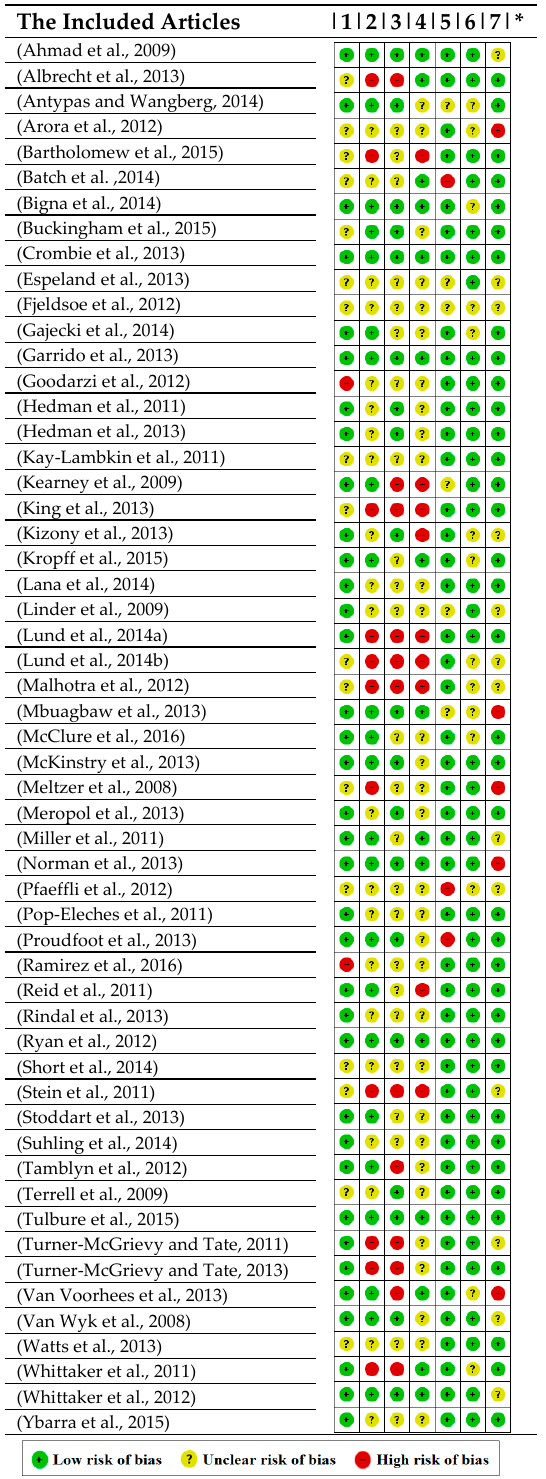
Table 1. The articles included in the review and our respective decision over 7 Cochrane risk of bias items.